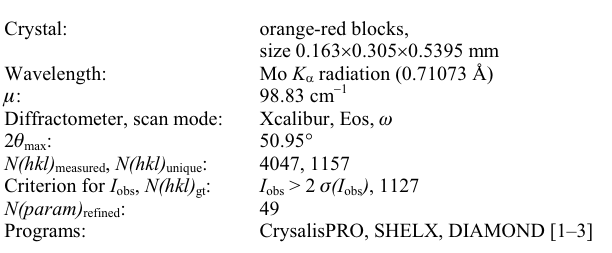
Table 1. Data collection and